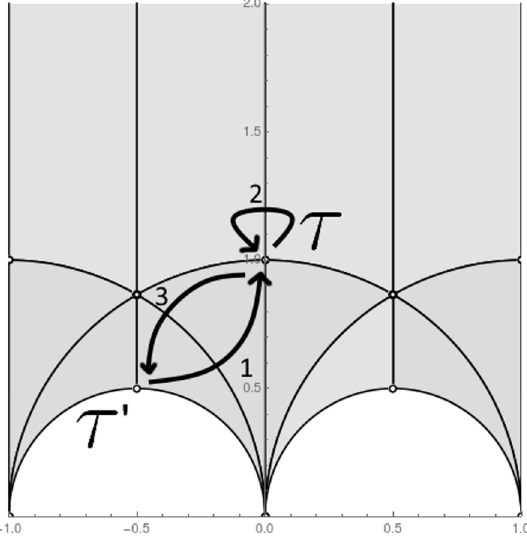
Figure 1 . An example of the applied methodology to find the stabilisers of Γ N . The example shown is for Γ 2 , where the arrows denote the actions of different elements, γ − 1 , γ i , γ , for 1,2,3 respectively, following the convention of the